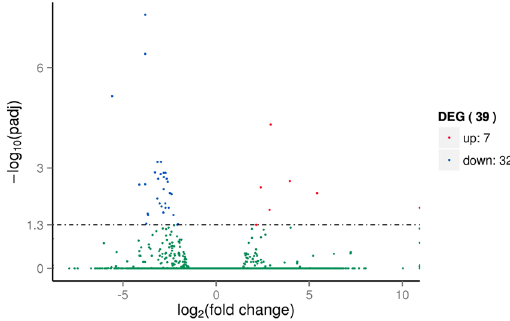
Figure 1. Analysis of differentially expressed unigenes in GFD (GF drought-stressed) vs. GFC (GF control).